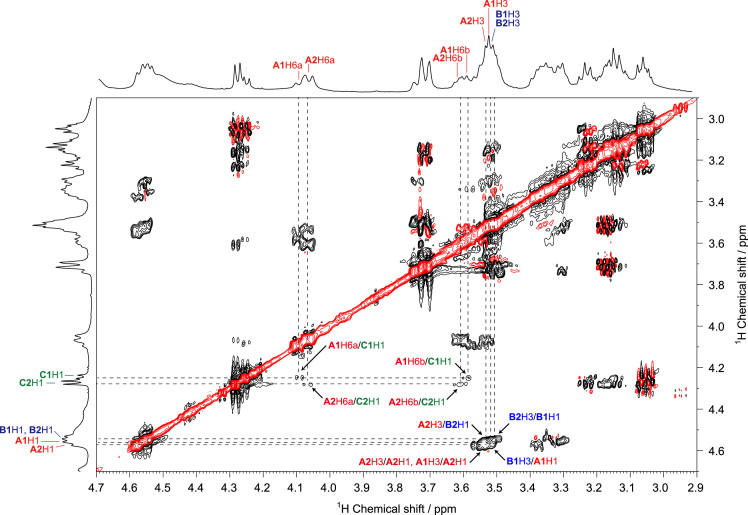
ROESY spectrum of the water-soluble β-(1→3, 1→6)-glucan from A. pullulans in DMSO-d6 at 363 K. The arrows indicate the interresidual correlations between A2H3–B2H1, A1H3–A2H1, B1H3–A1H1, A2H3–B2H1, B2H3–B1H1, A2H6a–C2H1, A2H6b–C2H1, A1H6a–C1H1, and A1H6b–C1H1 via glycosidic bonds.